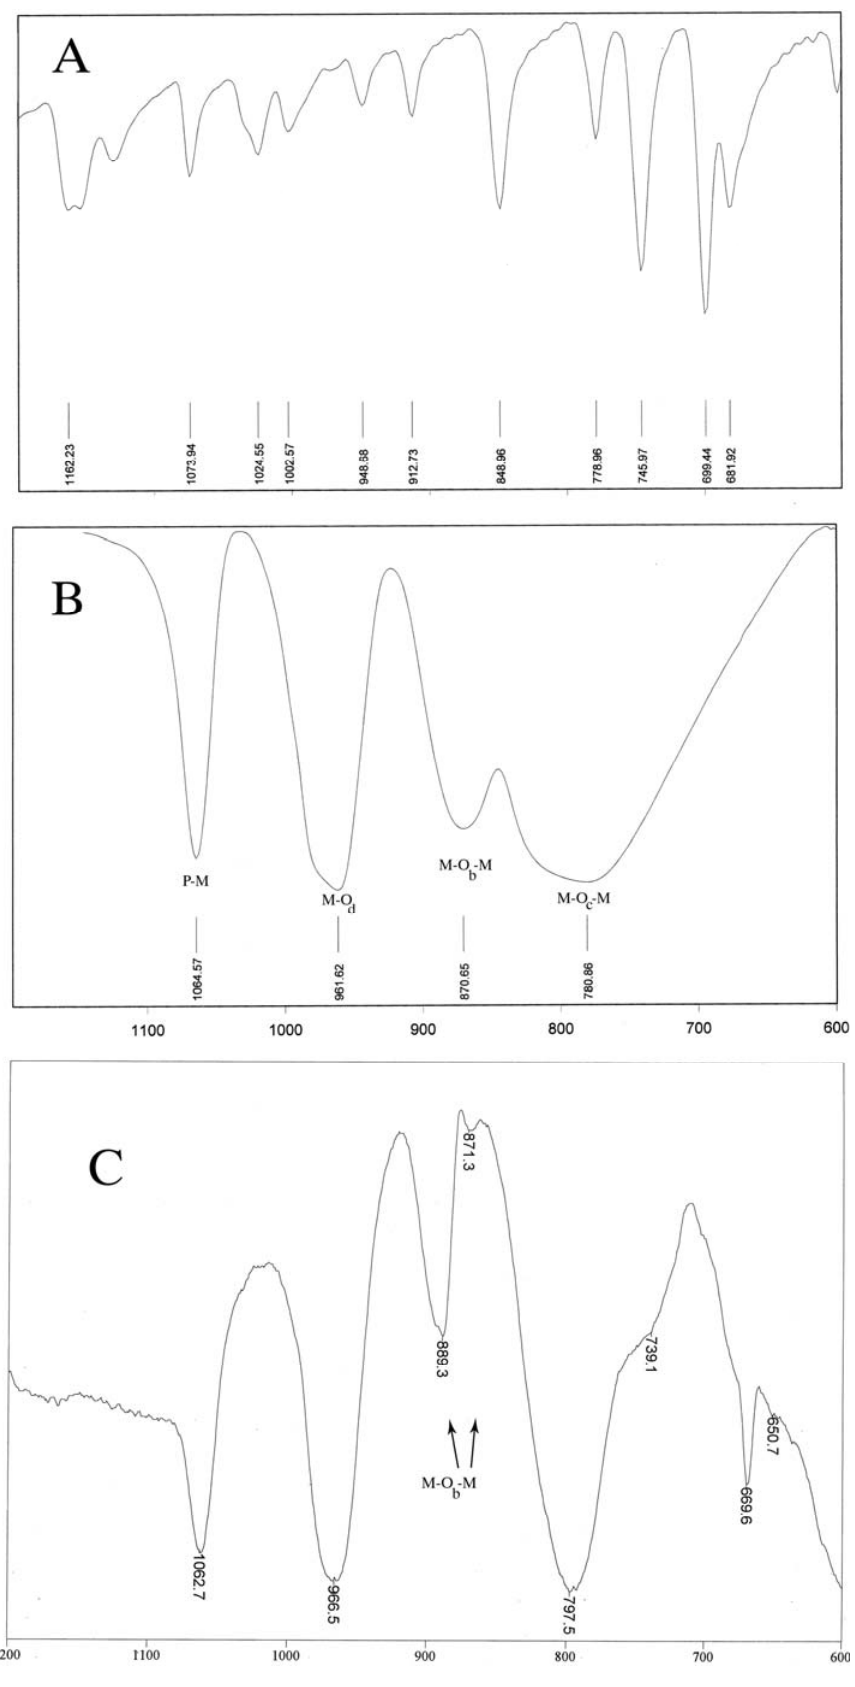
PMo O (B), phenylalanine and H 3 12 40